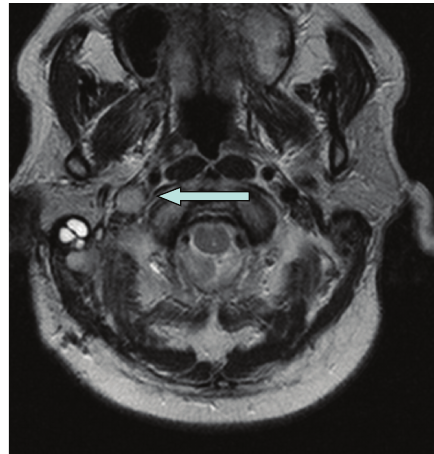
Figure 2: Axial T2 weighted image shows the lack of the normal flow void in the right internal jugular vein secondary to extension of the meningioma. Compare this finding to the normal appearing internal jugular flow void on the left